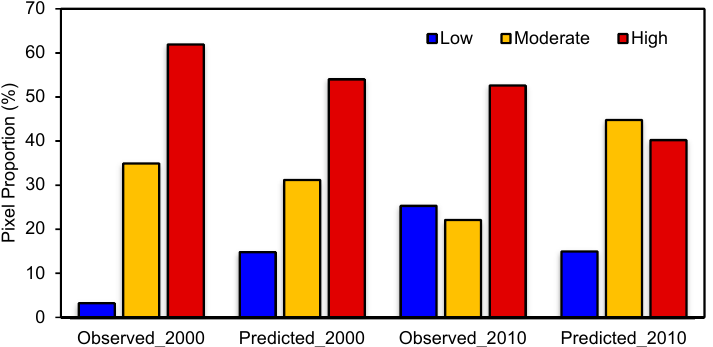
Figure A3. Comparison of pixel proportions of low, moderate and high severity levels between observed fire severity maps and predicted severity maps.